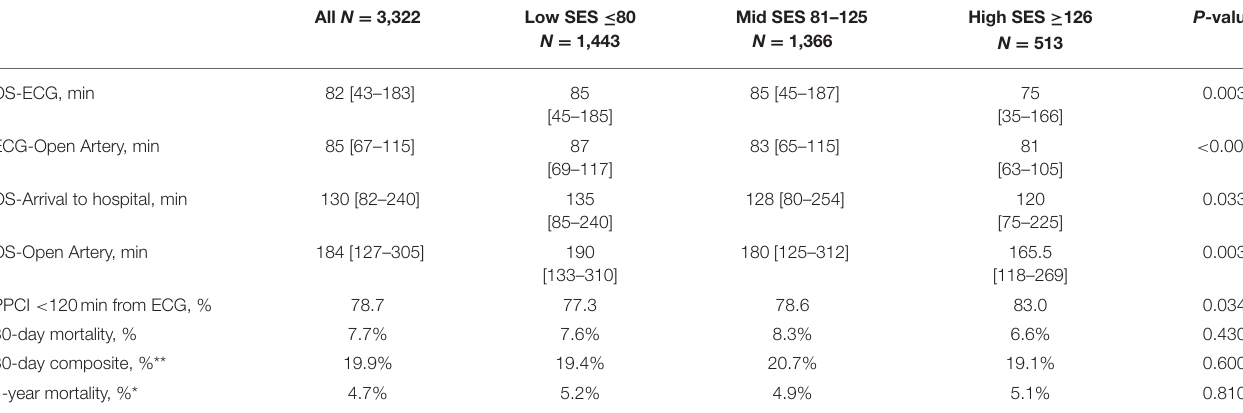
TABLE 3 | Delays in initial medical care, diagnosis, and revascularization according to SES during the period